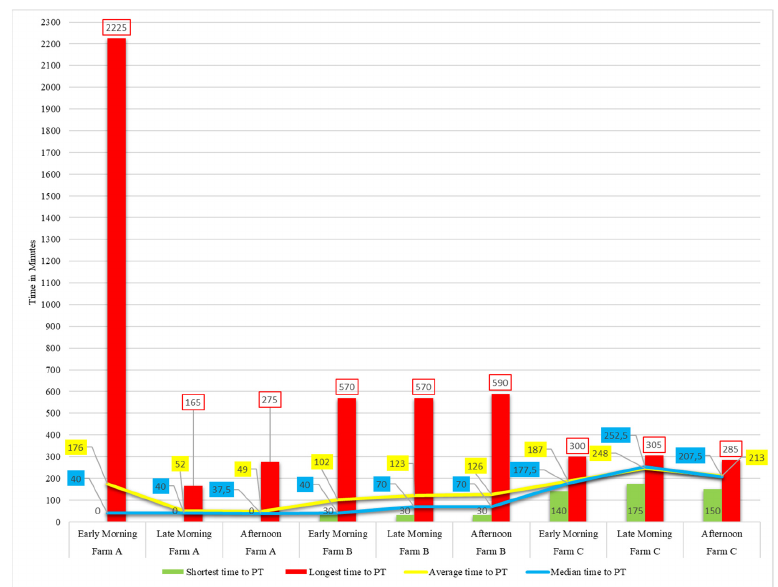
Figure 10. Time in minutes to reach PT = 0 °C on Western Cape farms. Source: [13].